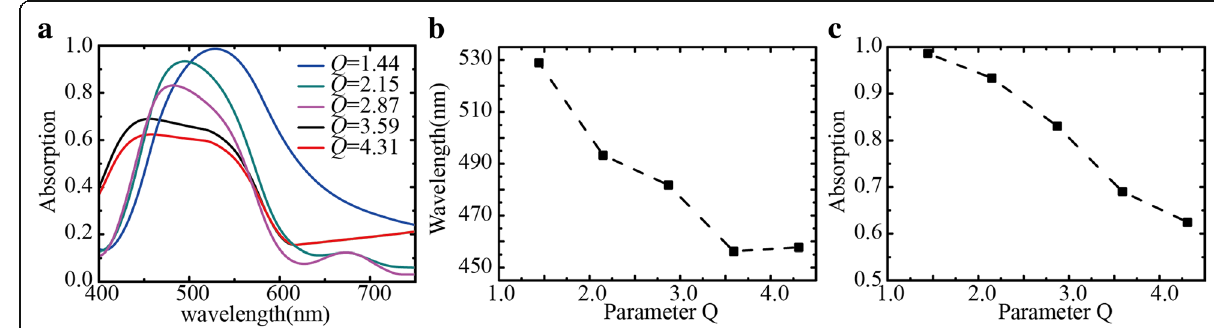
Fig. 5 Dependence of resonance on atomic ratio Q . a Absorption spectra for different Q parameters. b Dependence of peak wavelength on Q and its c dependence of peak intensity on